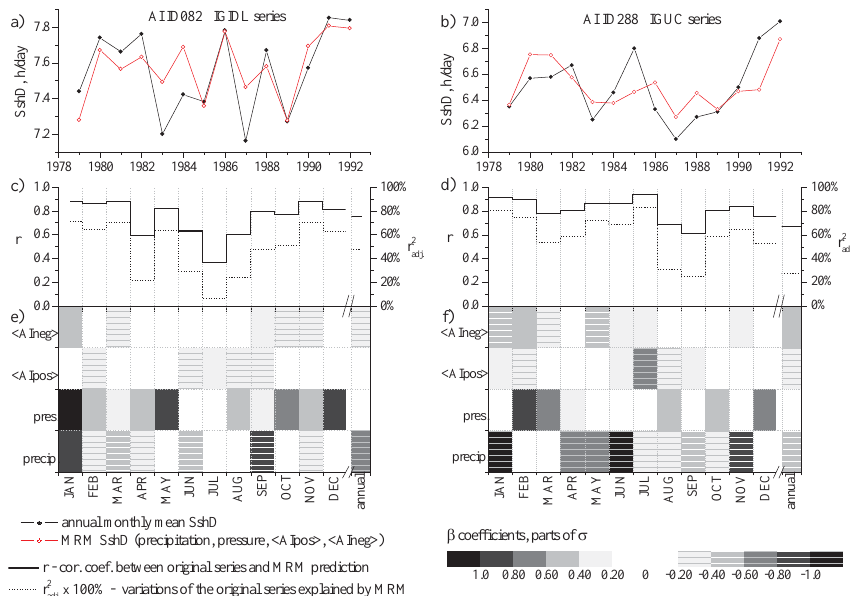
Figure 5. Multiple regression model (MRM) predictions and parameters for the annual and monthly sunshine duration from the IGIDL (a, c, e) and IGUC (b, d, f) series. (a – b) Measured annual SshD series vs. the corresponding MRM predictions. (c – d) Correlation coefficients r between the MRM and the original series for the monthly data, and the variance explained by the MRMs ( r 2 (in parts of standard deviation σ) for each of the regressors for the monthly